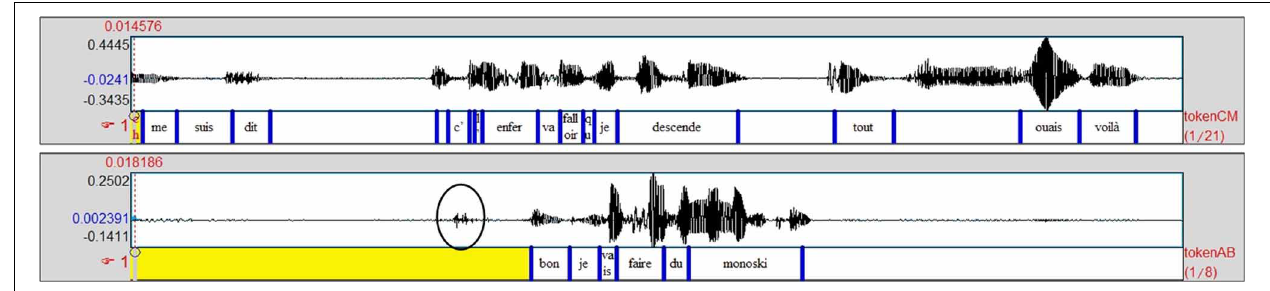
FIGURE 5 | Simultaneous reported speech from the storyteller and the listener.